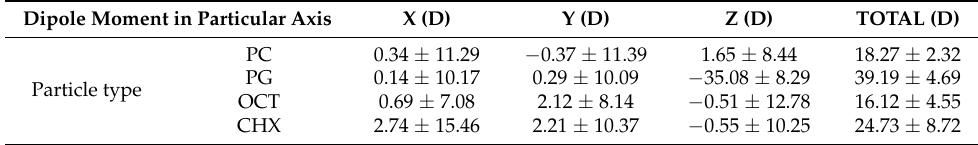
Table 2. Derived Dipole Moments of Lipids and Agents from MD